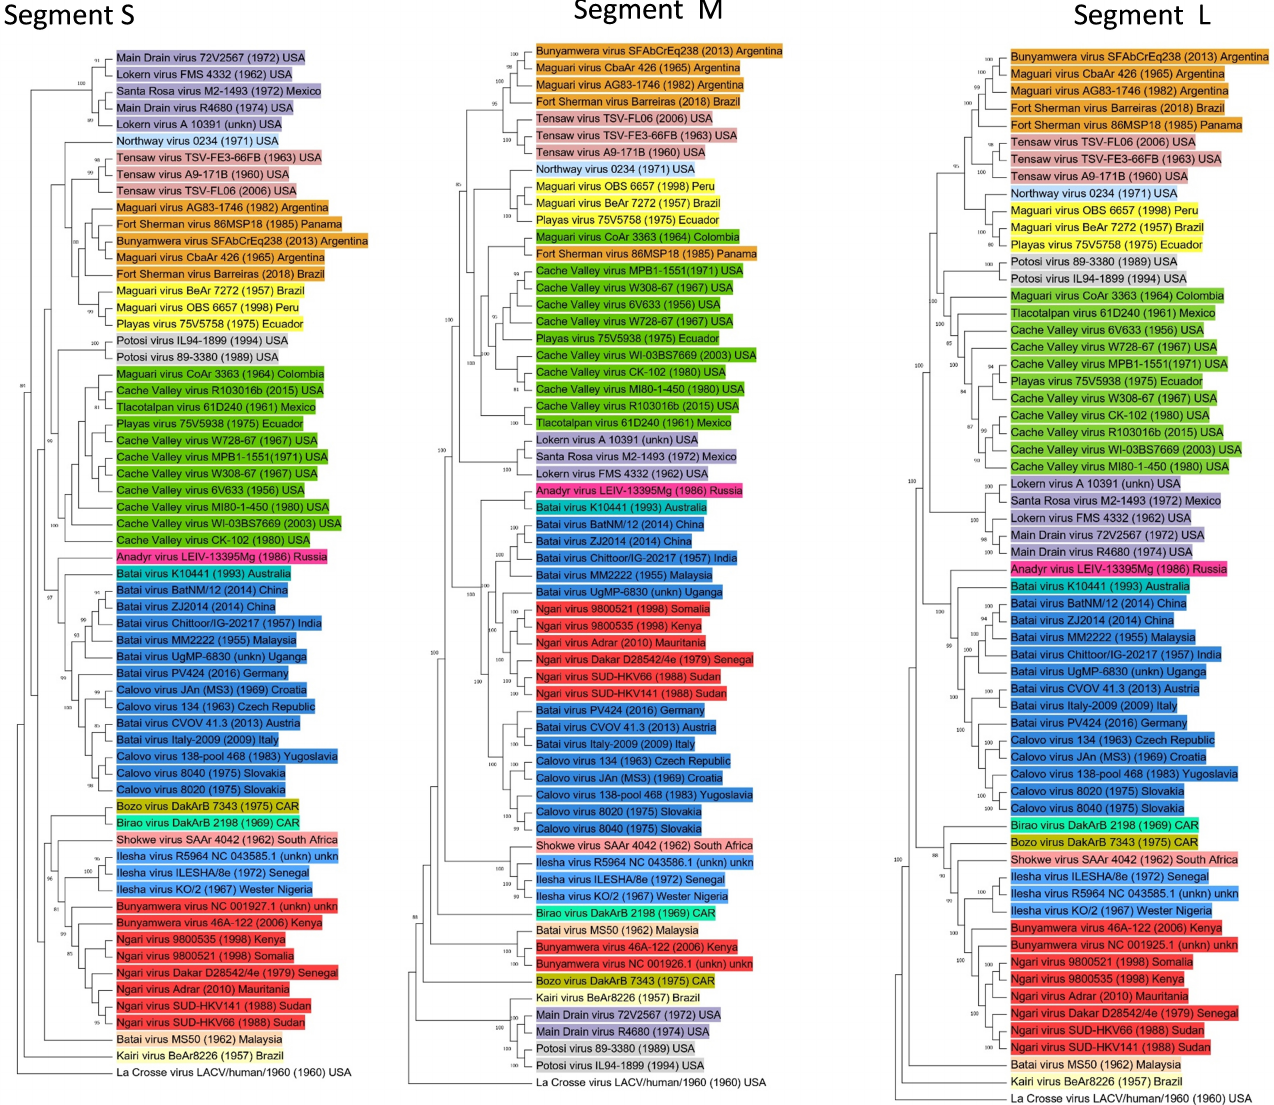
Figure 2. Phylogenetic trees for complete L, M, and S sequences of Bunyamwera serological group members (at the nucleotide level). The attribution to the orthobunyavirus species is indicated by colored highlighting as in Figure